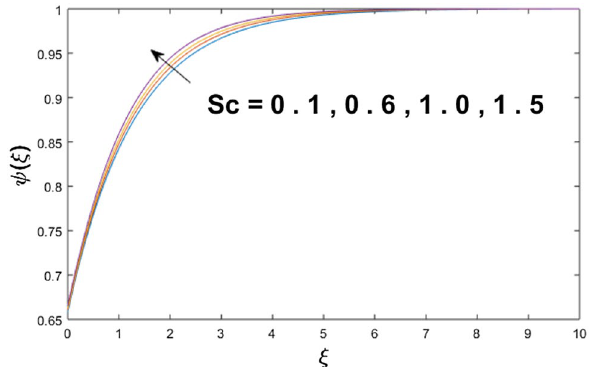
Figure 12. Variations of S c to ψ(ξ) .